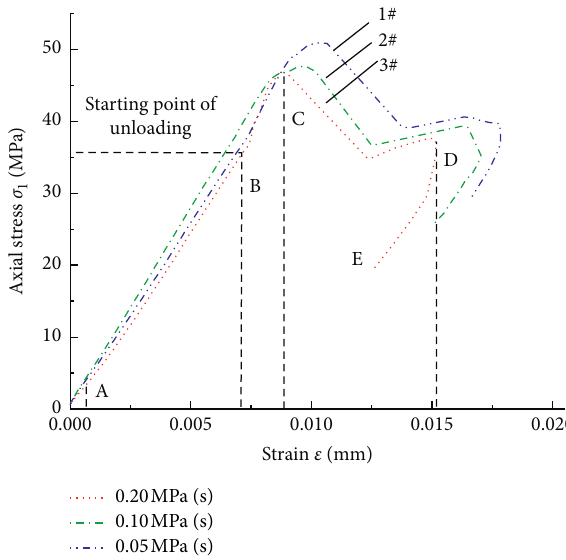
Figure 5: Stress-strain curves at different unloading